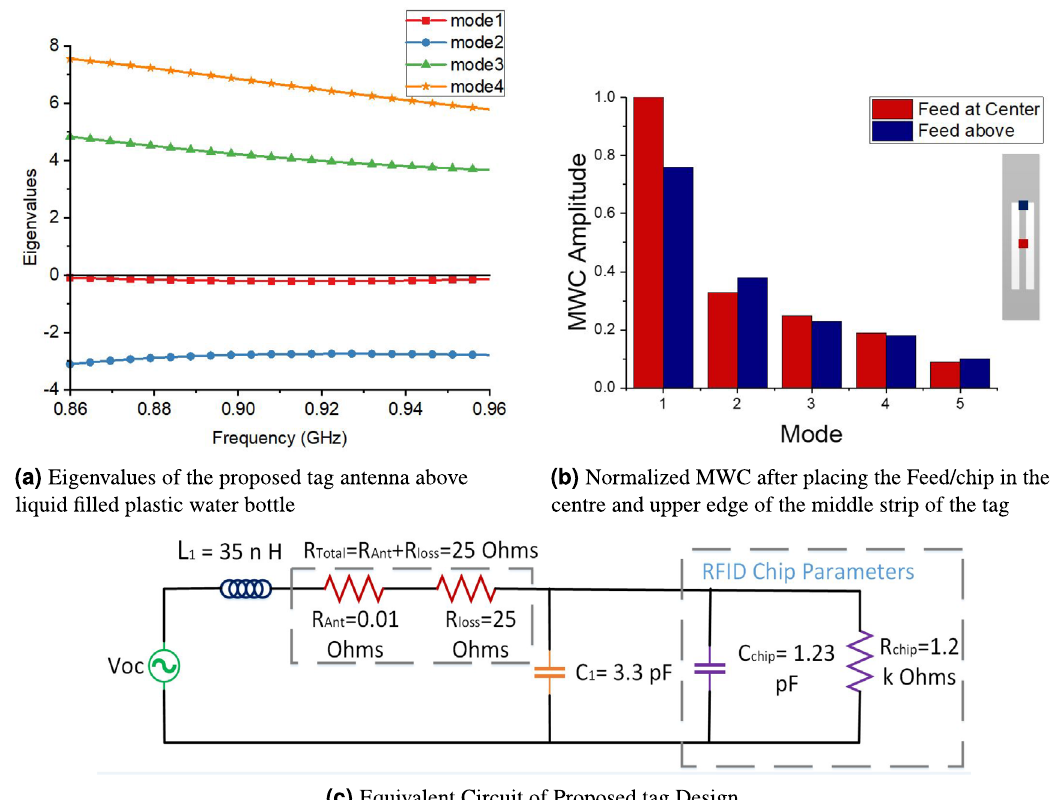
Figure 6. Performance analysis of proposed tag antenna above liquid filled plastic water